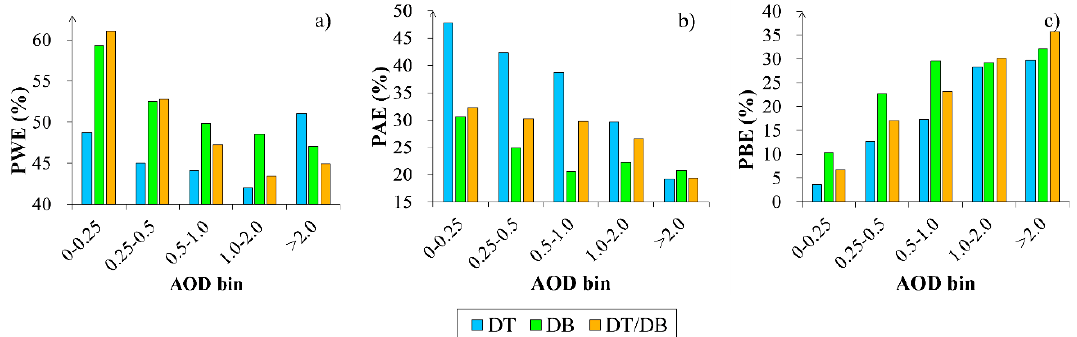
Figure 2. Validation of MOD04 C6.1 DT ( a ), DB ( b ), and combined DT / DB ( c ) AOD retrievals at 10 km resolution against AERONET measurements for the years 2000–2016. The dashed lines = EE lines, black solid line = 1:1 line, and red solid line = regression line.